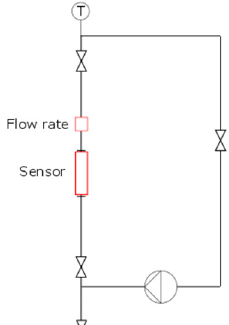
Figure 3. Flow loop schematic used for internal flow experiments (Reynolds number range of 500–50,000).